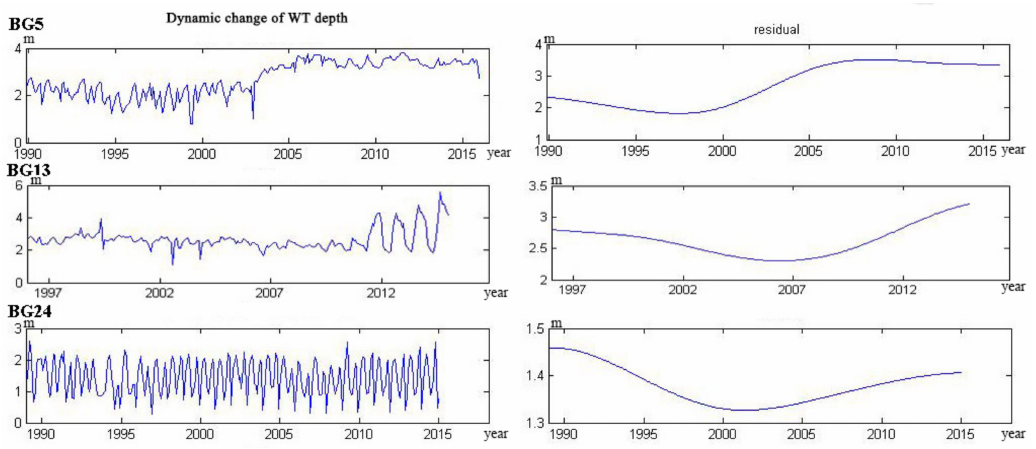
Figure 9. Empirical Modal Decomposition of the third type of curve.